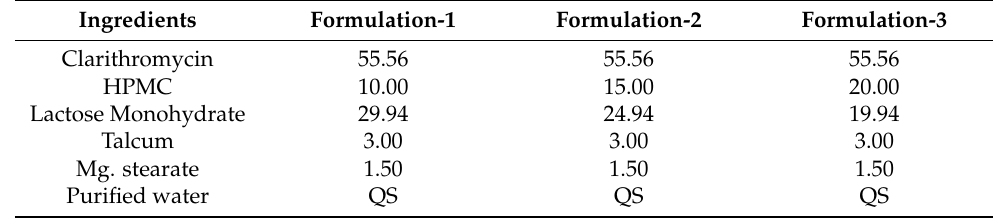
Table 2. Composition of sustained-release clarithromycin matrix